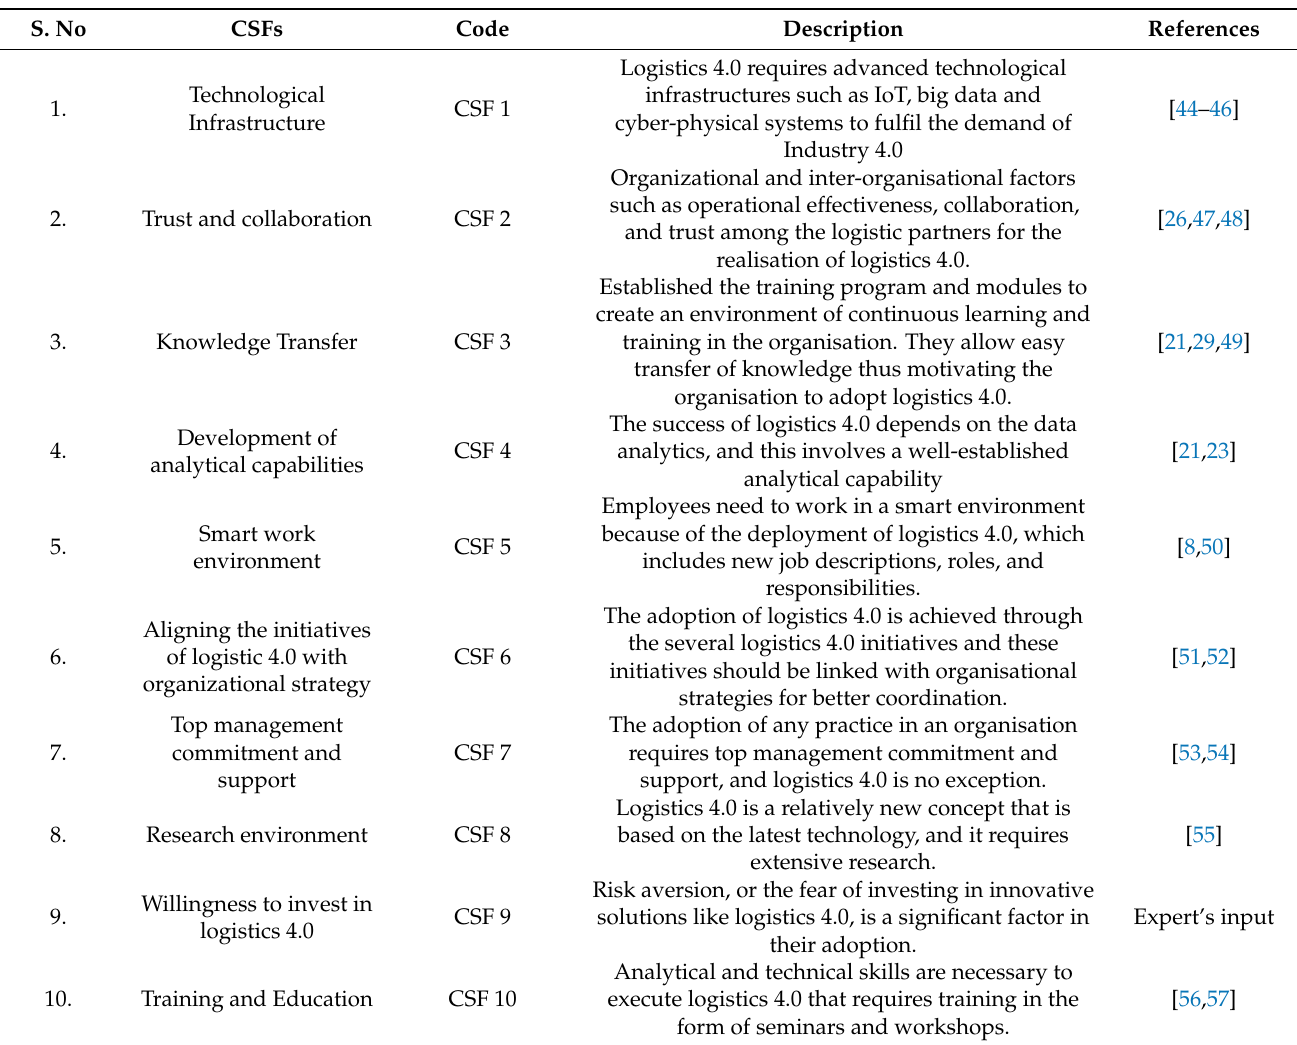
Table 3. CSFs of logistics 4.0